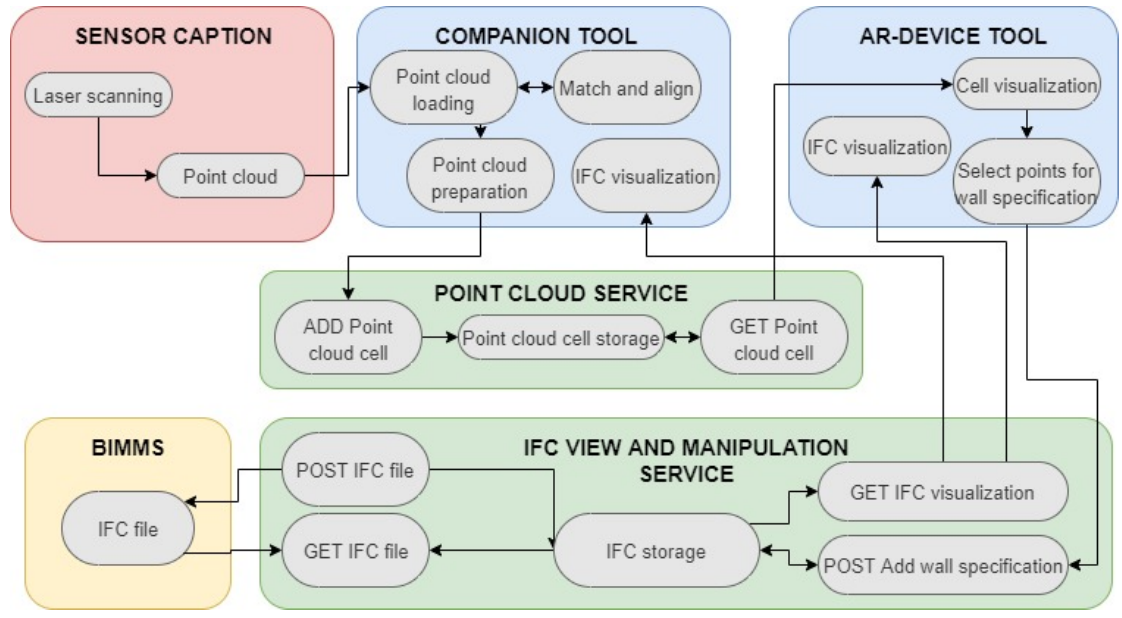
Figure 4. Workflow of the fast mapping of buildings .